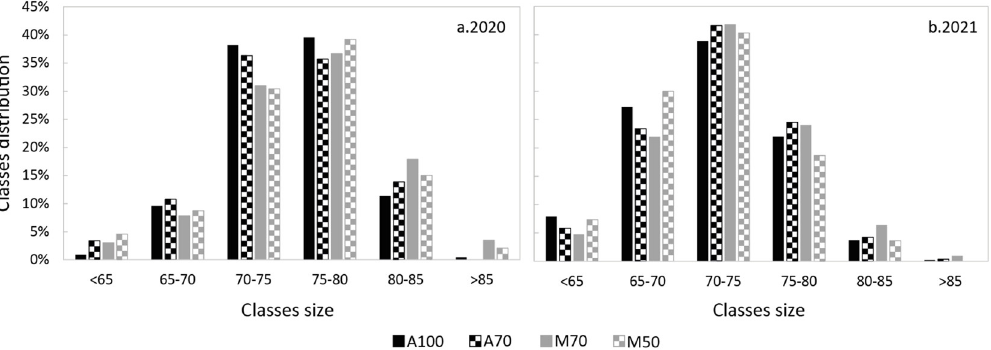
Figure 7. Size class distribution values for each irrigation treatment of fruit diameters ranging from